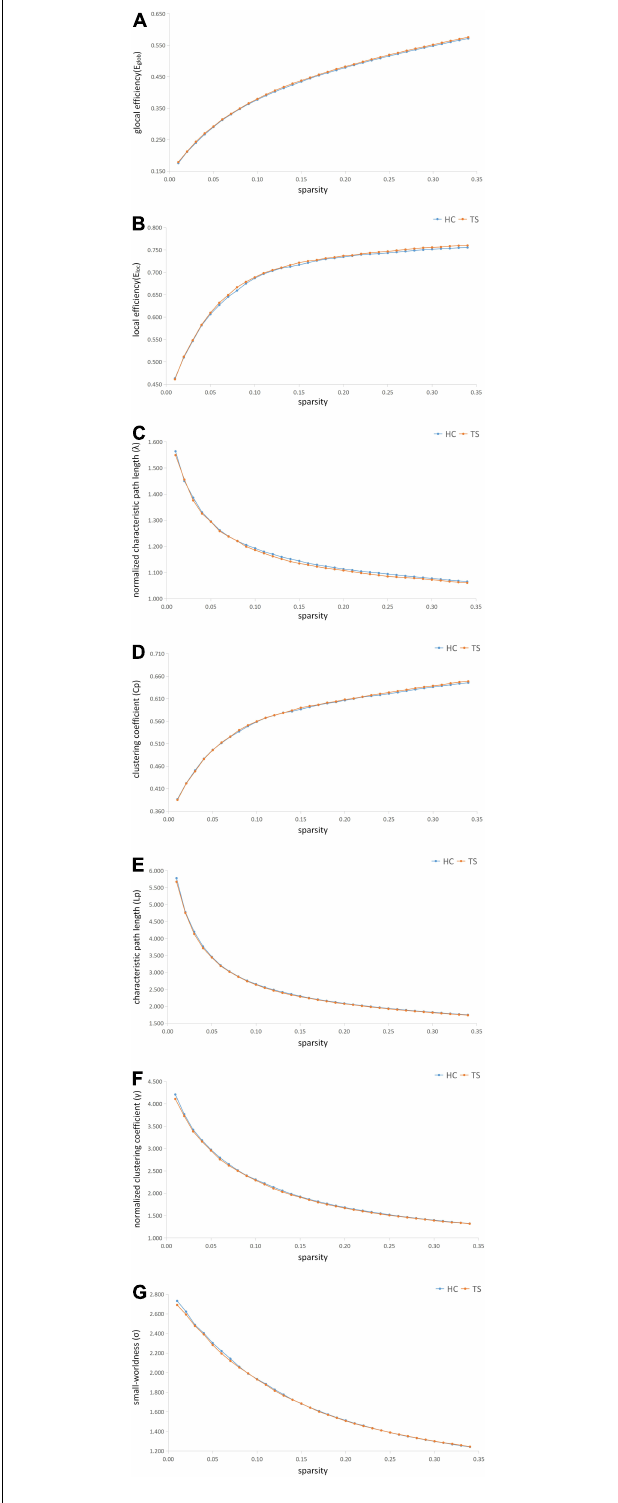
FIGURE 3 | The metrics of the structural connectome of the sparsity threshold in global efficiency (A) , local efficiency (B) , normalized characteristic path length ( λ ) (C) , clustering coefficient (Cp) (D) , characteristic path length (Lp) (E) , normalized clustering coefficient ( γ ) (F) , small-worldness ( σ ) (G) ,